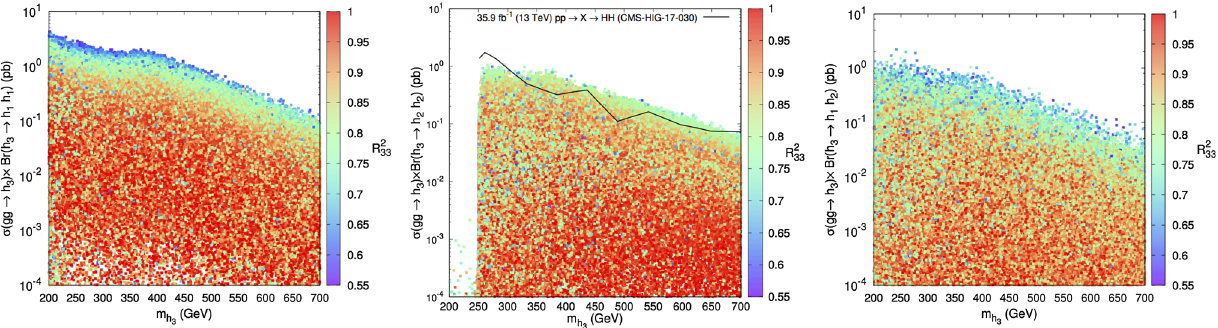
Fig. 12 Correlation between Br ( h 3 → AZ ) and Br ( h 3 → H ± W ∓ ) versus R 2 (right panel)